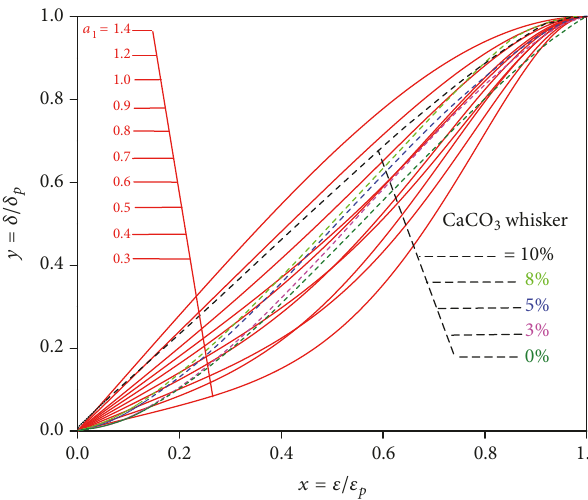
Figure 11: The calculated curve contrast to the test curve.